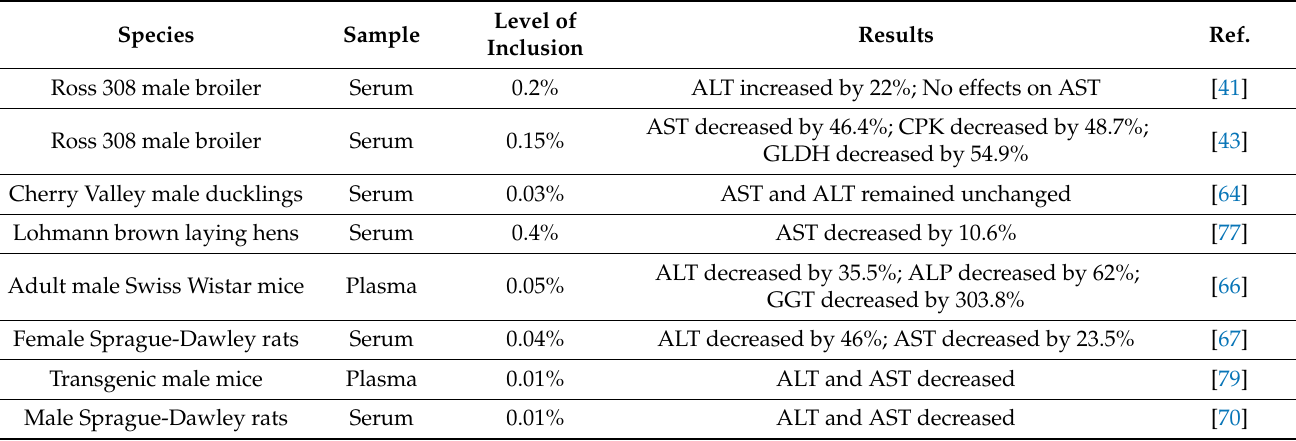
Table 2. MSM inclusion in diets and the effect on liver function in comparison with controls used in different traits.